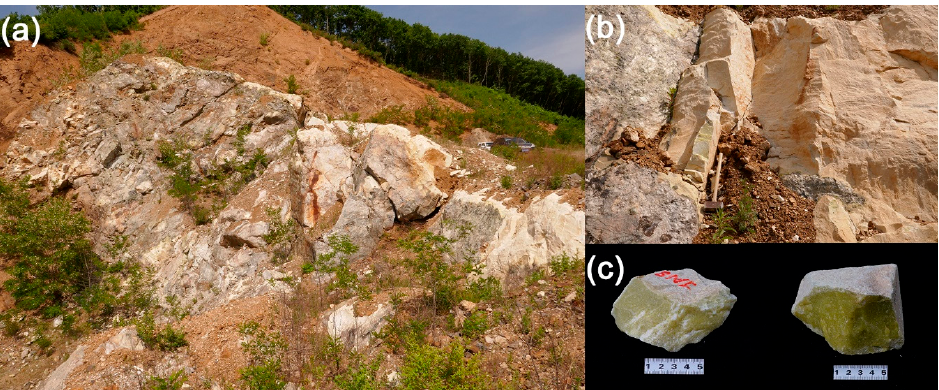
Figure 2. Photographs of jianite: ( a ) Full field view of the outcrop, which is ~10–15 m long and ~4–5 m wide; ( b ) A close-up view of the outcrop; ( c ) Representative photo of two specimens.